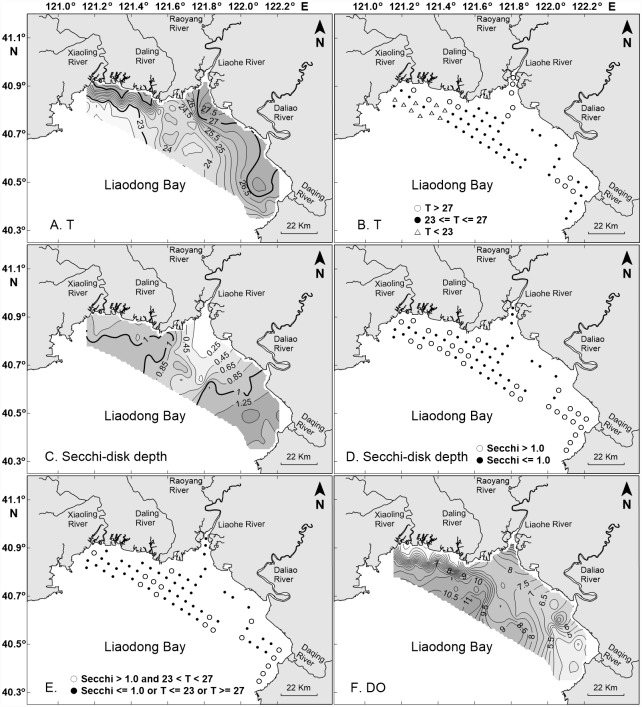
Contour maps and/or corresponding location maps of temperature (Panels A and B, in °C), Secchi-disk depth (Panels C and D, in meters), Secchi-disk depth associated with temperature (Panel E), and dissolved oxygen (DO, Panel F, in mg L–1).